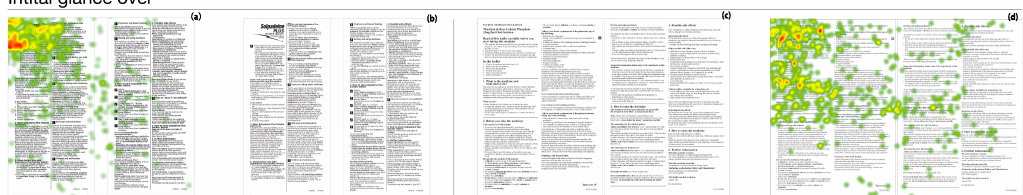
Figure 4. The result of the eye-tracking experiment for the first 30 s (shown by heat-map images); the warmer the color gets, the more the attention was gained in the section. ( a ) The field of view while looking at sample 1; ( b ) sample 1; ( c ) the fields of view while looking at sample 2; ( d ) sample